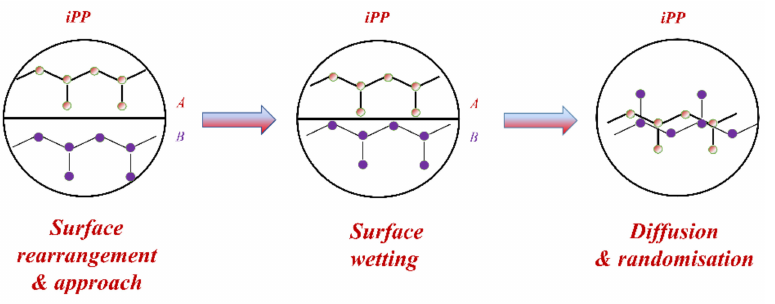
Figure 9. Mechanisms involved in self-healing via molecular inter-diffusion (Authors’ self-created